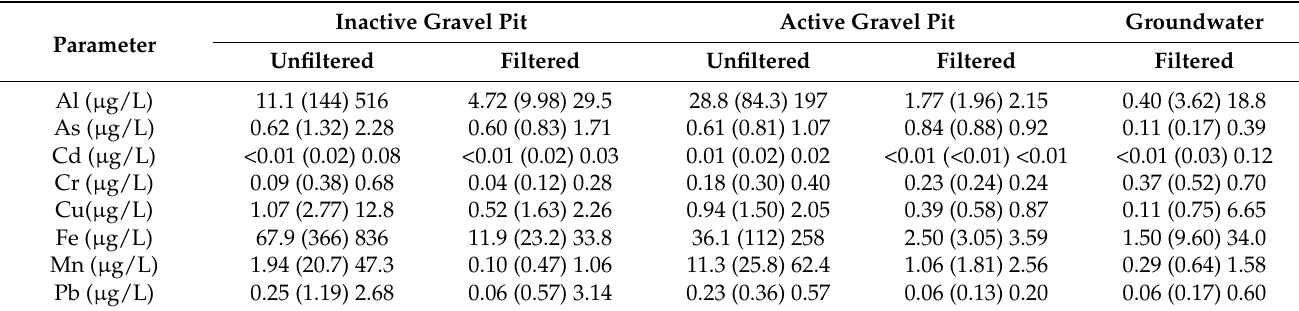
Table 2. Comparison of metal concentrations in gravel pits (unfiltered and filtered pairs) and ground- water samples. Data are shown as minimum and maximum values with mean values in parentheses.